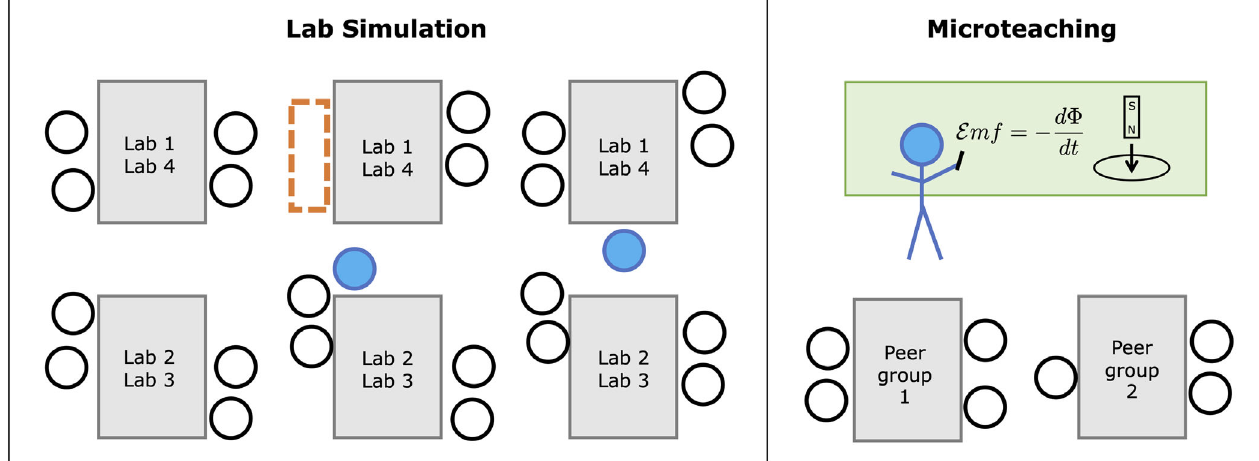
FIG. 4. Schematics of the classroom settings for the lab simulation and microteaching activities. Left panel: top view of the lab simulation classroom. Each gray rectangle represents a lab table, the empty circles represent the participants acting as students, the filled blue circles represent the two participants acting as TAs, and the orange dashed rectangle indicates where those two participants will sit when it is their turn to be students. Right panel: each microteaching session has GTAs taking turns to facilitate a problem solving session, while the rest of the participants act as students. Figure adapted from Ref.